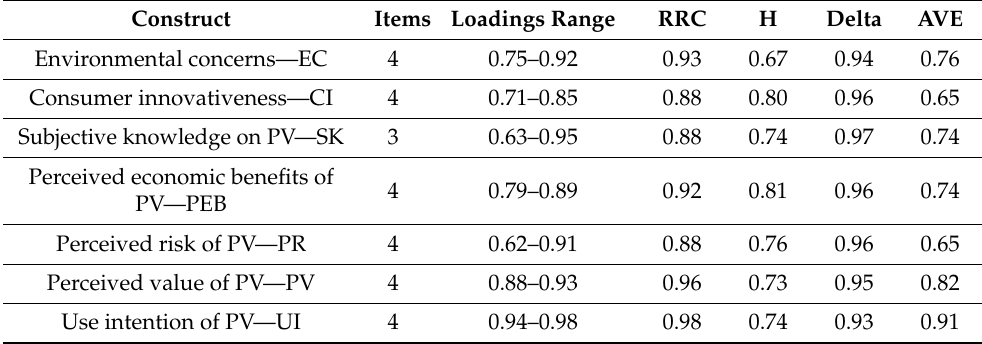
Table 2. Reliability and validity of measurement